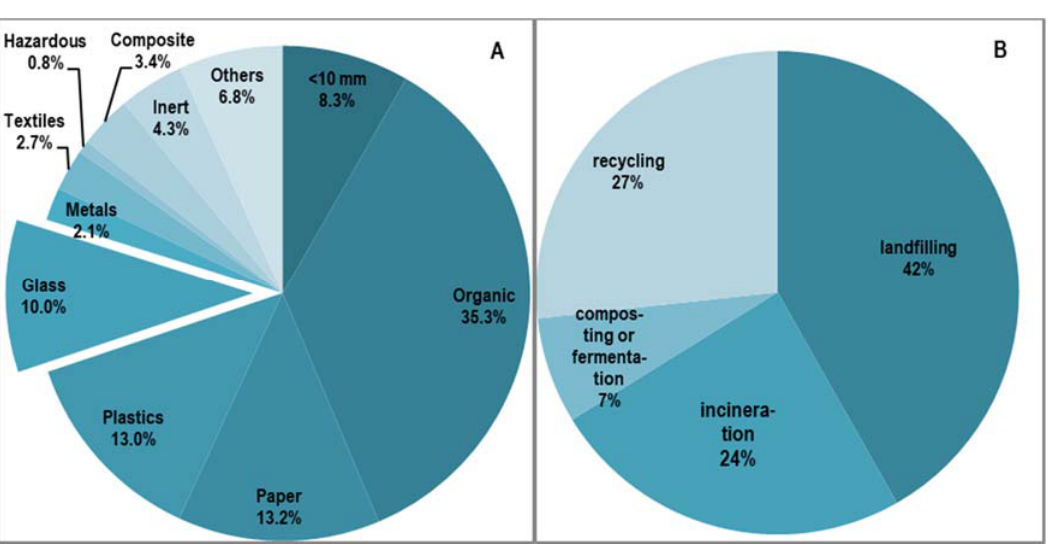
Figure 1. Morphological composition (National Waste Management Plan 2022) ( A ) [3] and ways of managing the MSW generated in Poland in 2017 (Directive 2008/98/EC) ( B ) [4].